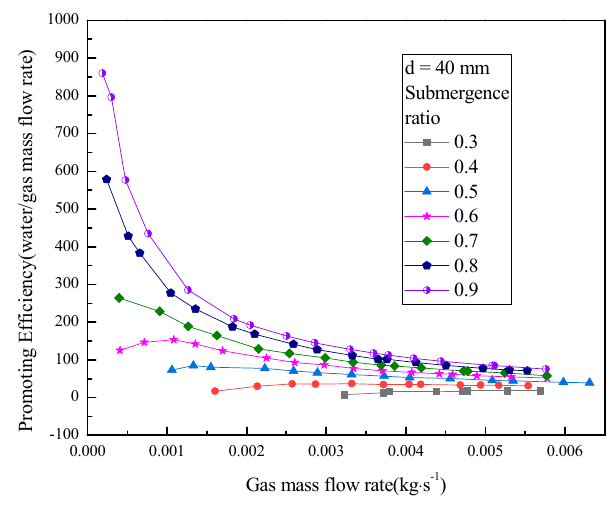
Figure 3. Changes of promoting efficiency with gas flow using 8 mm-wide circular holes.